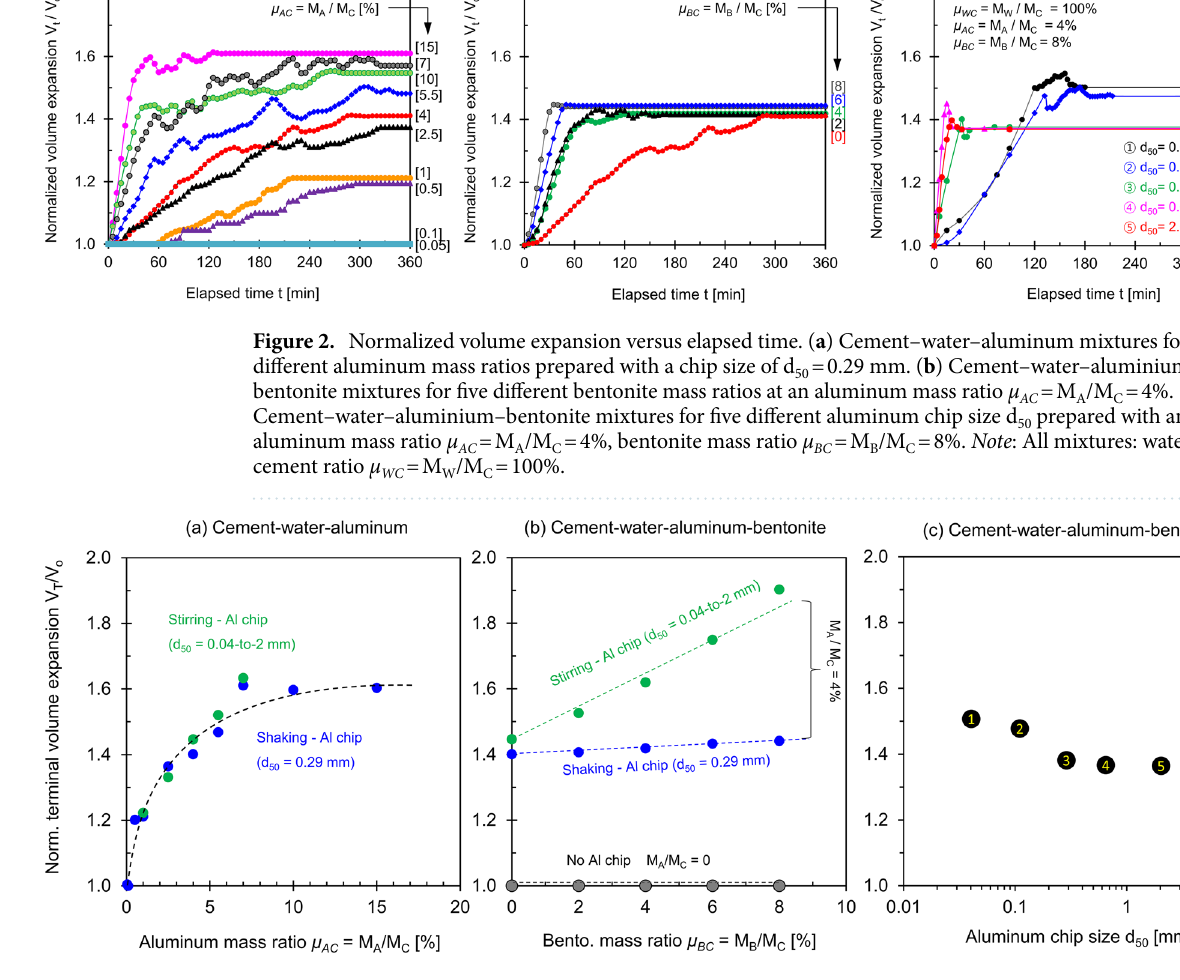
Figure 3. Normalized terminal volume expansion V T /V o after 24 h in terms of the initial mixture volume at time t = 0. ( a ) Cement–water–aluminum mixtures for different aluminum mass ratios M A /M C prepared using the two mixing methods, stirring and shaking. ( b ) Cement–water–aluminium–bentonite mixtures for five different bentonite mass ratios μ BC prepared using the two mixing methods. ( c ) Cement–water–aluminium– bentonite mixtures for five different aluminum chip sizes d 50 . All mixtures: water-cement ratio μ WC = M W / M C =